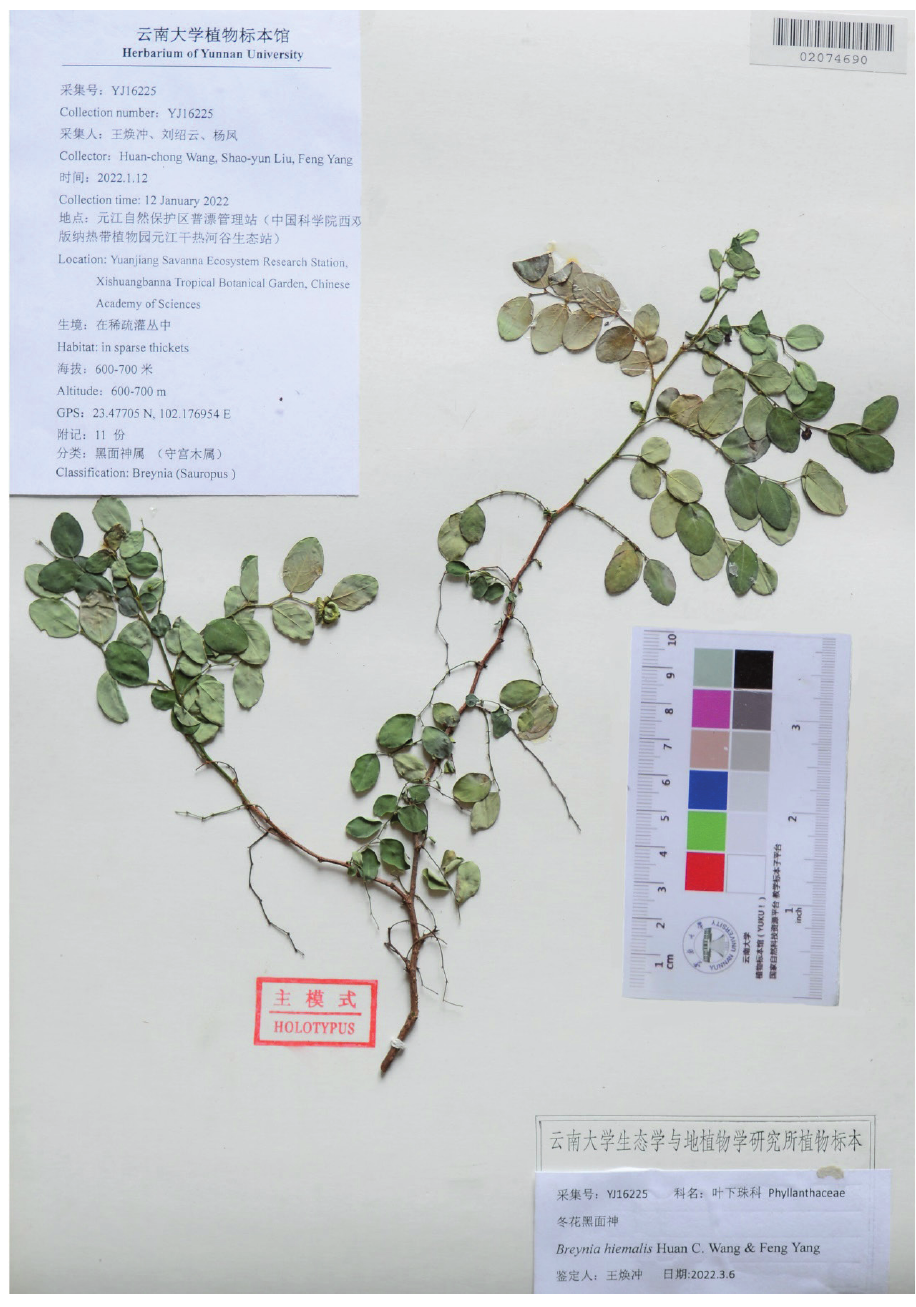
Figure 3. Holotype of Breynia hiemalis